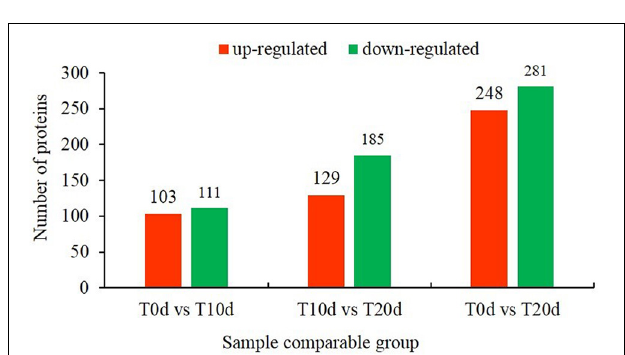
FIGURE 4 | Number of differentially expressed proteins in the T0d vs. T10d, T10d vs. T20d, and T0d vs. T20d comparison groups.